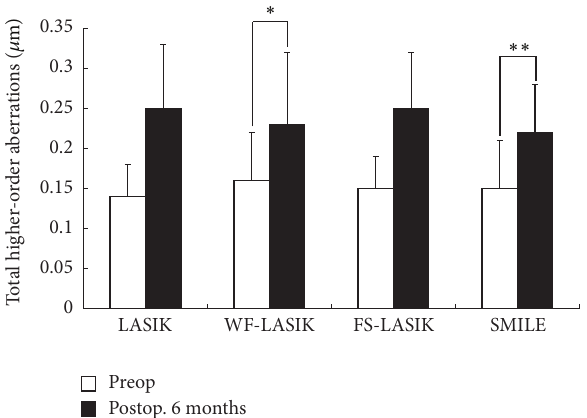
Figure 1: Comparison of the total higher-order aberrations (HOAs) changes in four groups. Comparison of the induced total HOAs between wavefront-guided LASIK and both LASIK and femtosec- ond laser-assisted LASIK ( ∗ 𝑃 values are 0.001 and 0.023, resp.). Comparison of the induced total HOAs between small incision lenticule extraction (SMILE) and both LASIK and femtosecond laser-assisted LASIK ( ∗∗ 𝑃 values are < 0.001 and 0.018, resp.).